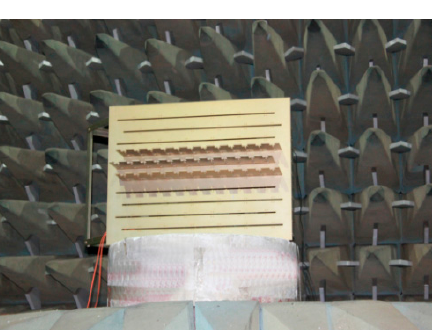
Figure 16. The reflector.